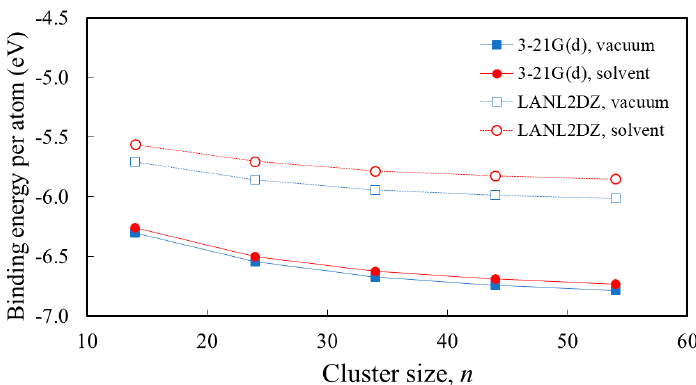
Figure 4. Dependence of the binding energy per atom, [ E n − nE Ti − ( 2 n + 2 ) E O − 4 E H ] / ( 3 n + 6 ) , on the size of Ti n O 2 n +2 H 4 clusters ( n = 14, 24, 34, 44, 54), calculated by B3LYP functional and 3-21G(d) or LANL2DZ basis sets in vacuum or in water solvent.